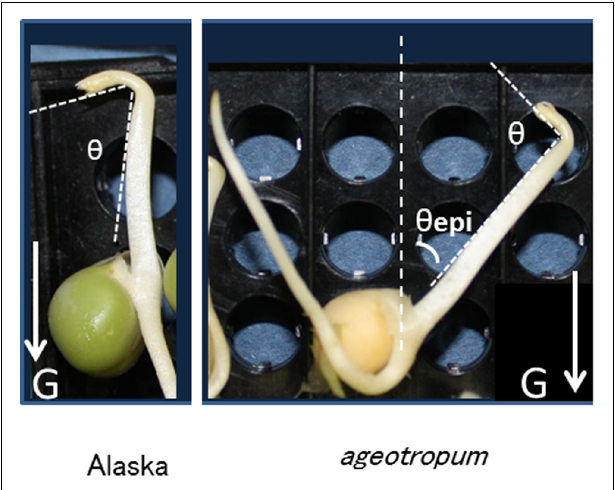
FIGURE 1 | Pea seedlings, cv.Alaska and agravitropic mutant, ageotropum , grown under 1- g in the dark at 23.5 ◦ C for 84 h asw (after supplying water to dry seeds), and the definition of hook angle ( θ ) and epicotyl bending ( θ epi ). The G arrows indicate the direction of gravity. In ageotropum the epicotyl extends in the direction of about 40 ◦ away from the seed axis, and the root elongates in the symmetric direction to the epicotyl. Note that the apical hook bends on the same side of the epicotyl as the cotyledons in both pea varieties.